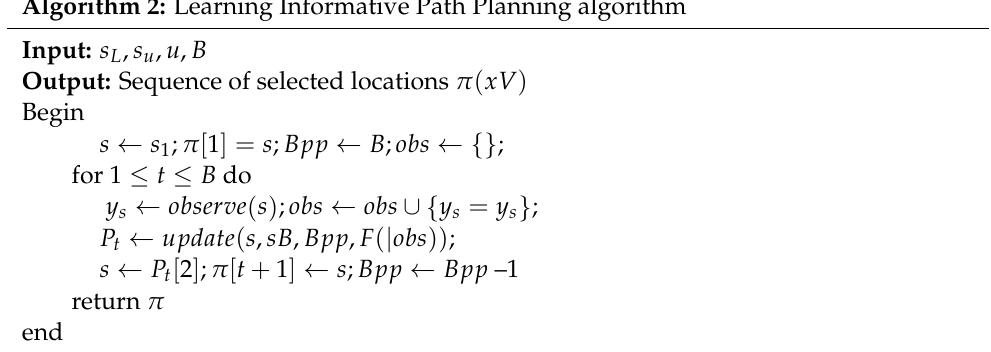
Algorithm 2: Learning Informative Path Planning